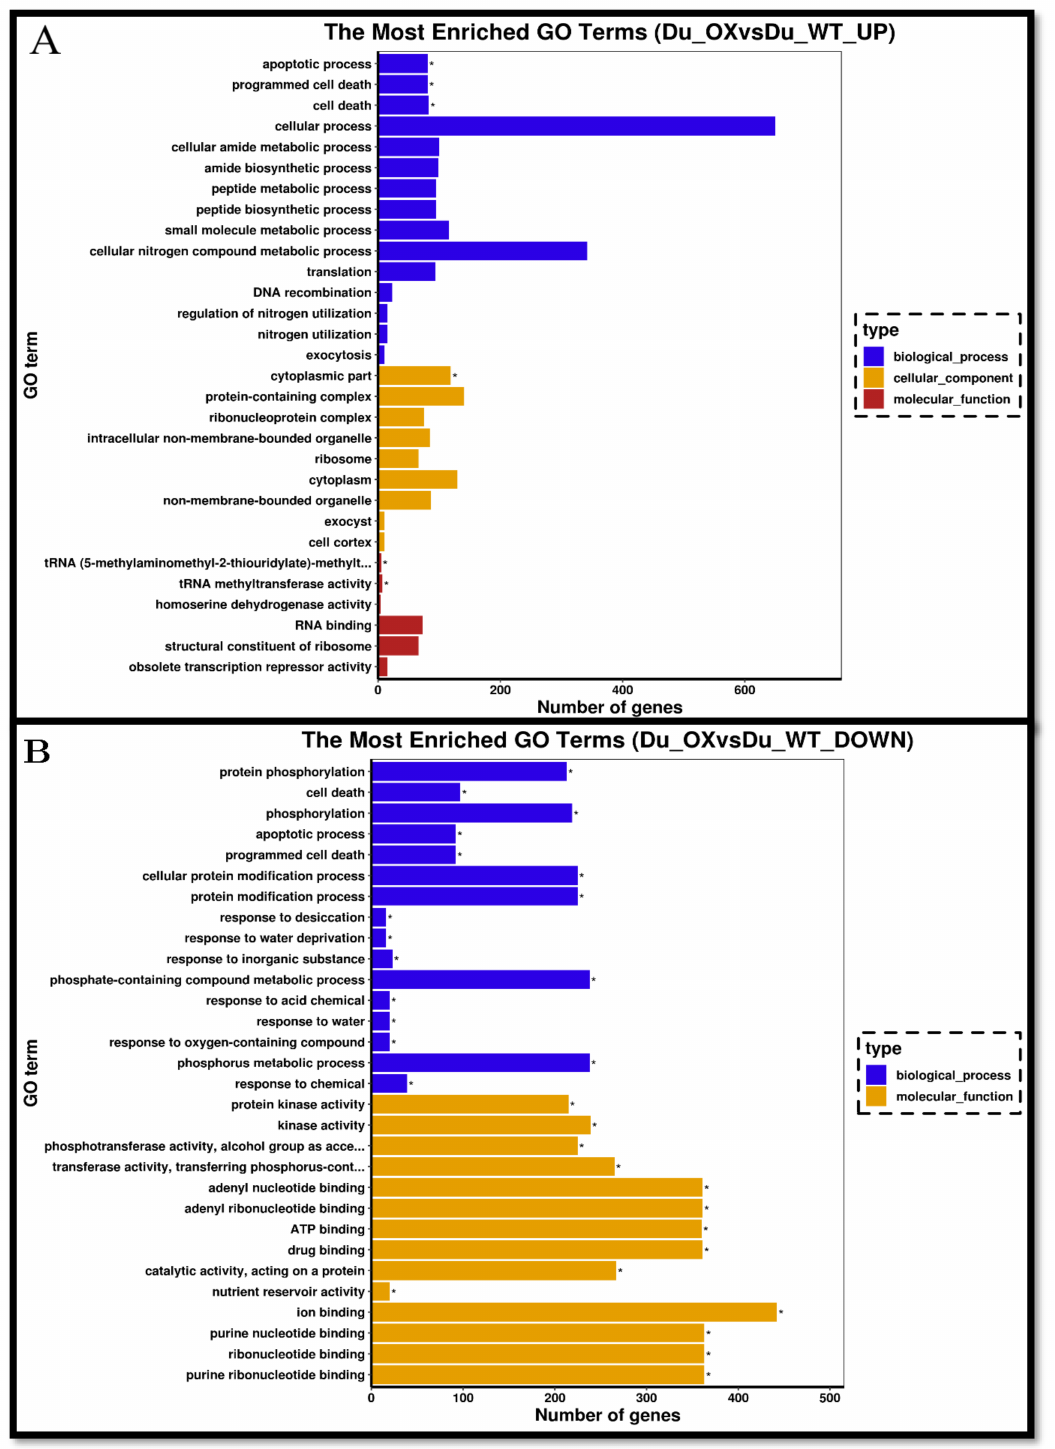
Figure 6. GO classification of up-regulated genes in the DU-OE line ( A ) and GO classification of down-regulated genes in the DU-OE line ( B